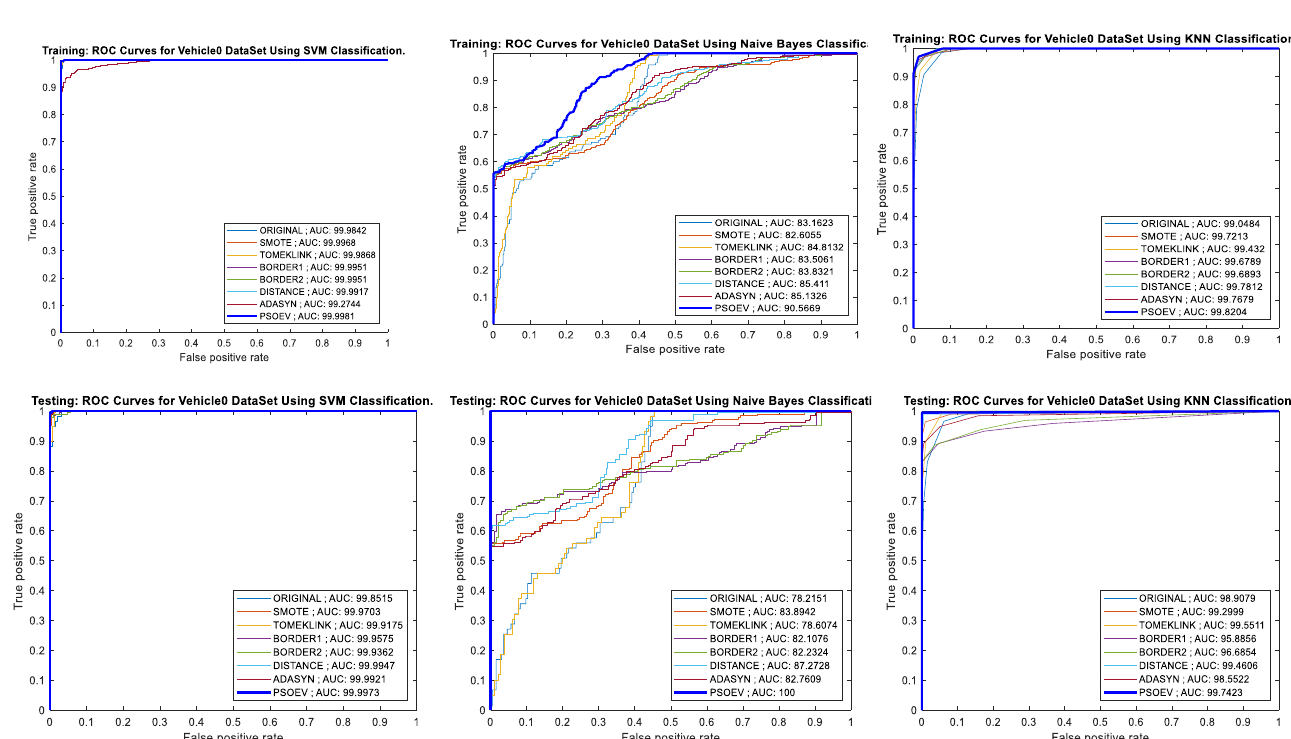
Figure 8. AUC-ROC curves of training and testing of Pima dataset using SVM, NB, and k -NN classification methods, respectively.